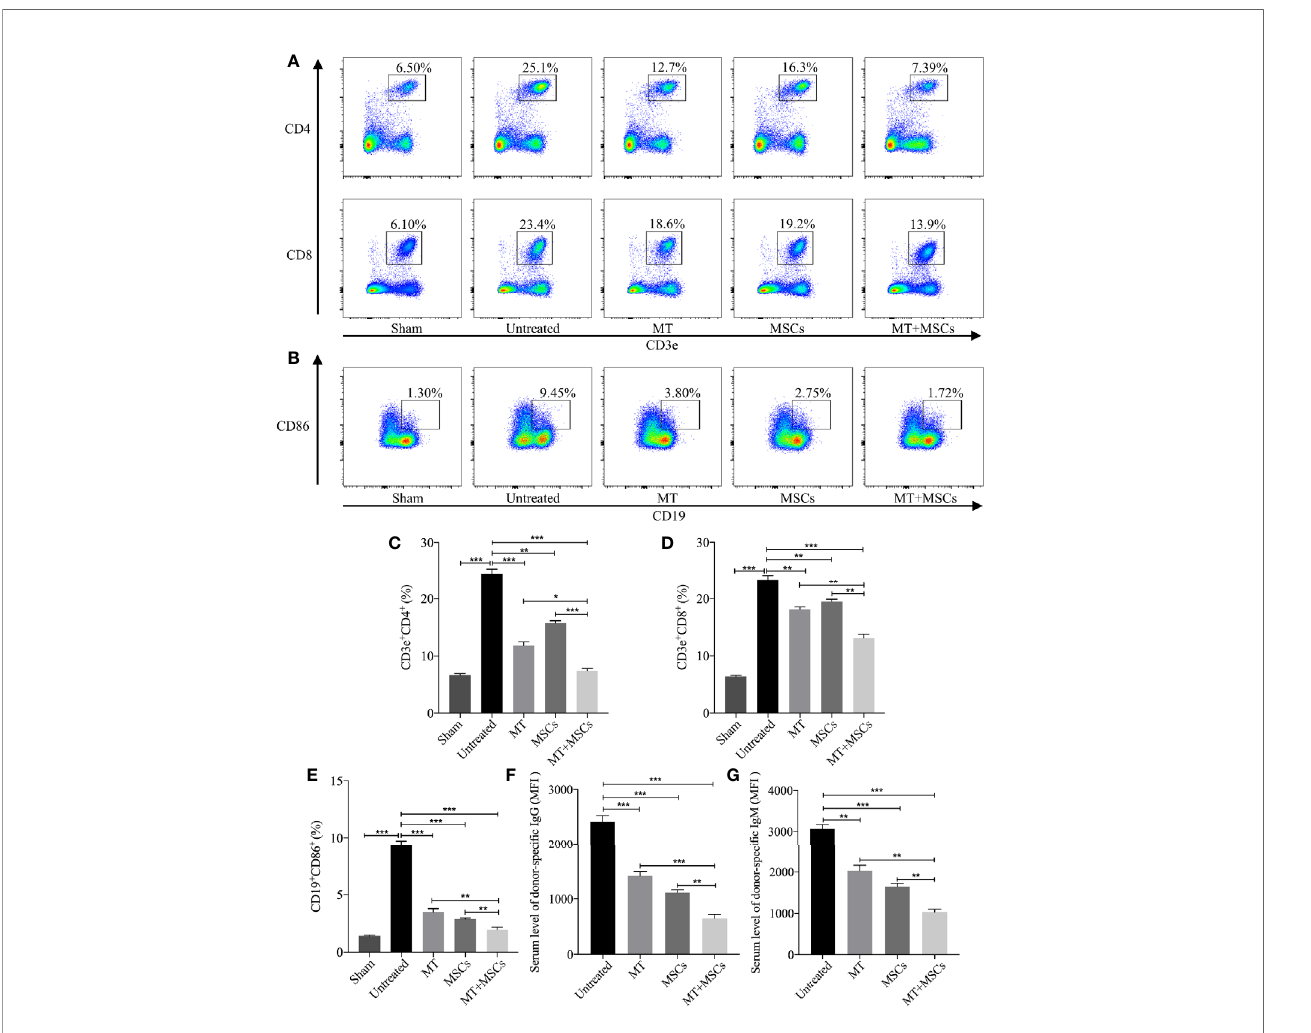
FIGURE 5 | MT acts synergistically with MSCs to reduce splenic CD4 + and CD8 + T cells, inhibit B cell activation and DSA production. Splenocytes are collected from the B6 recipient mice of each group at postoperative day 40. (A) The pseudocolor of CD4 + and CD8 + T cells in recipient splenocytes; (B) The pseudocolor of B (CD19 + CD86 + ) cells in vivo ; (C) The percentage of CD4 + T cells; (D) The percentage of CD8 + T cells; (E) The percentage of B cells; (F) The serum level of donor- speci fi c IgG; (G) The serum level of donor-speci fi c IgM. Statistical analysis is performed by one-way analysis of variance (ANOVA), n = 10 per group, * p <.05, ** p <.01, and *** p <.001. Bar graphs represent mean ± SEM. MT, melatonin; MSCs, mesenchymal stem cells; MFI, mean fl uorescence intensity. Data shown are representative of three separate